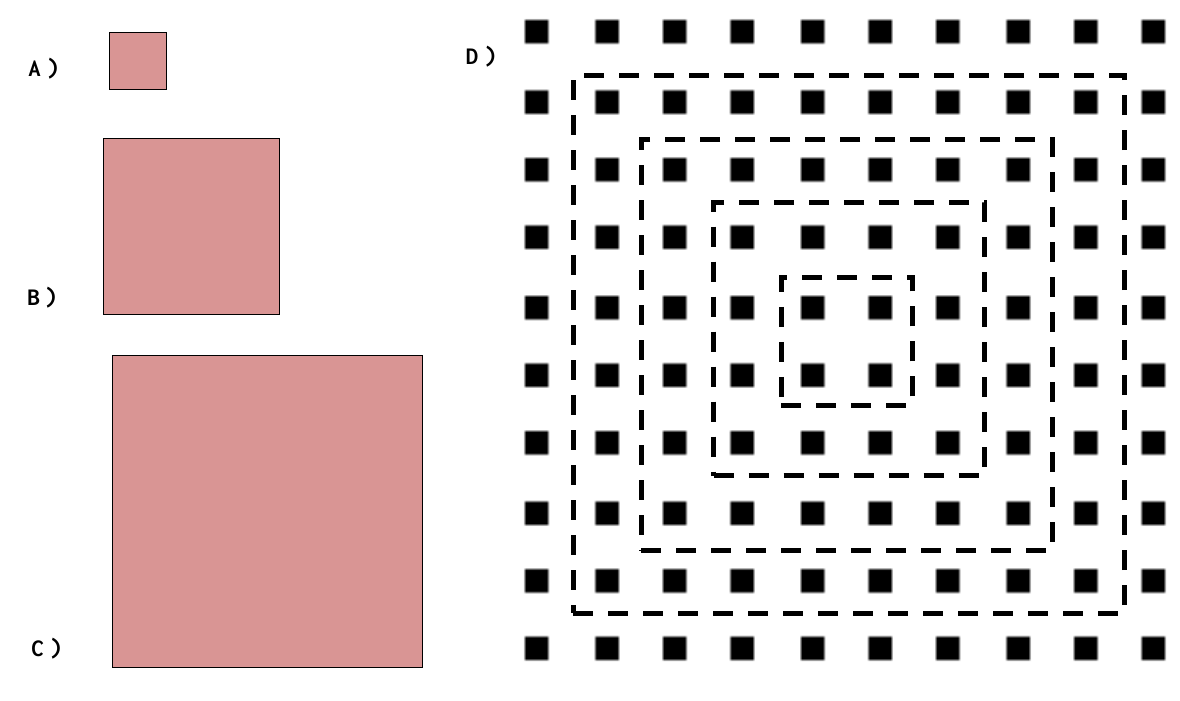
Figure 1. The eraser and target array sizes presented throughout the experiment. The size of the eraser was always 8 x 8 mm (A) at the start of a trial, and could grow to a maximum size of either 25 x 25 mm (B) or 44 x 44 mm (C) , depending on the experimental phase and how long a monkey waited to begin its response. In all phases, the target array could be presented in 1 of 5 sizes (D) . Here, each array size is represented by a dashed square surrounding a selection of target stimuli (only the target stimuli, and not the dashed squares, were visible during actual